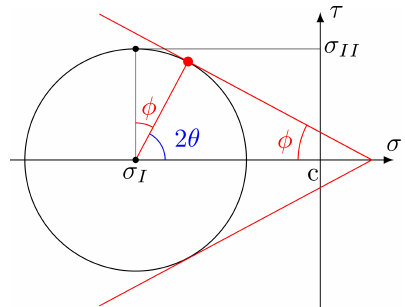
Figure A2. Mohr’s circle of stress (black) with the Mohr–Coulomb yield criterion (red) of the angle of internal friction φ (red) and co- hesion c in ( σ , τ ) space. From Eq. (A12), the deformation is created with an angle θ that can be represented in Mohr’s circle